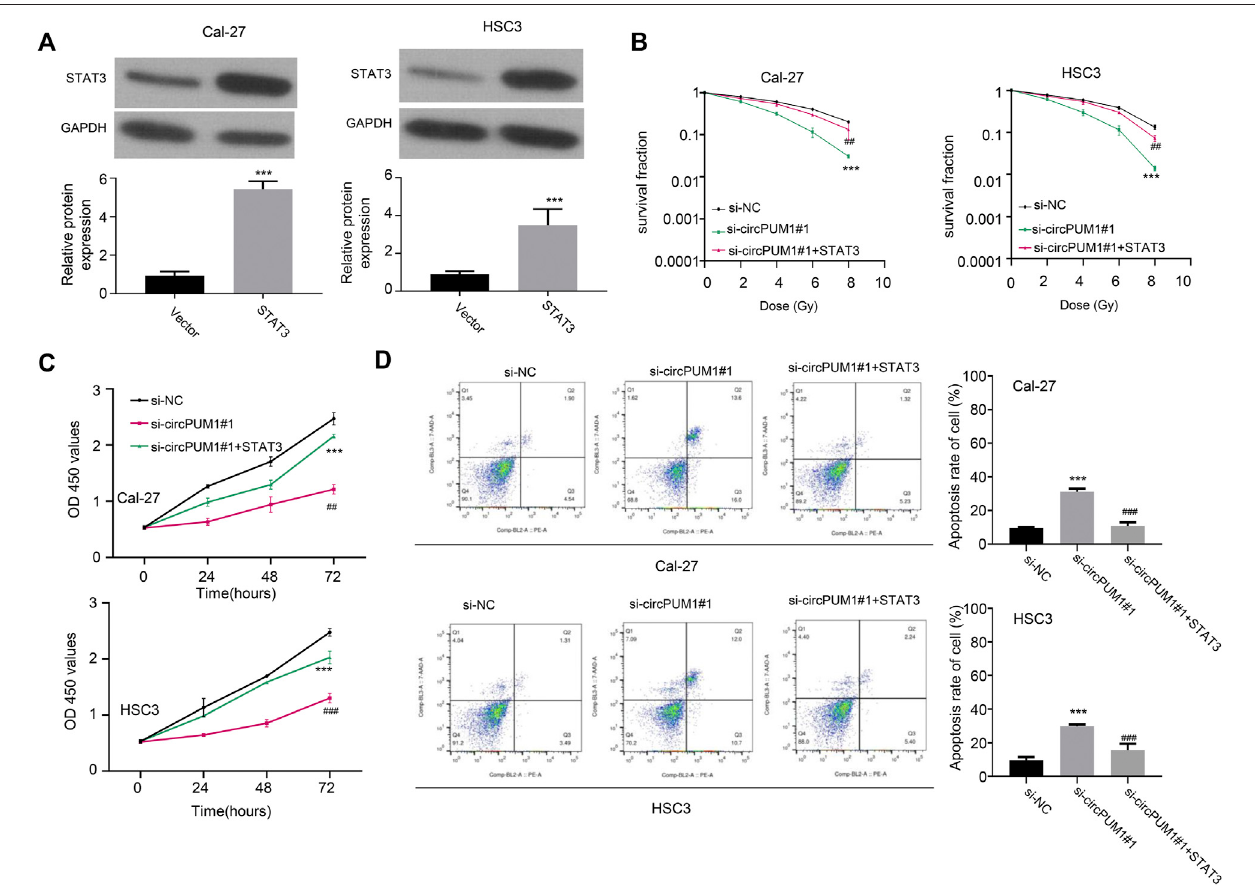
FIGURE 5 | Overexpression of STAT3 protein in OSCC cells (A) ; grouping of Cal-27 and hsc3 cells at 4Gy: the optical absorption values of Si-nc, si-CircPUM1#1, andsi-CircPUM1#1+STAT3at0h,24h,48h,and72 h (B,C) at450 nmwavelengthofdifferentgroupsofcellsunderdifferenttimeperiodsofradiation;knockdownofsi- CircPUM1#1 and cotransfection of STAT3 plasmid induced apoptosis (D) . p < 0.01 ( pp ) and p < 0.001 ( ppp